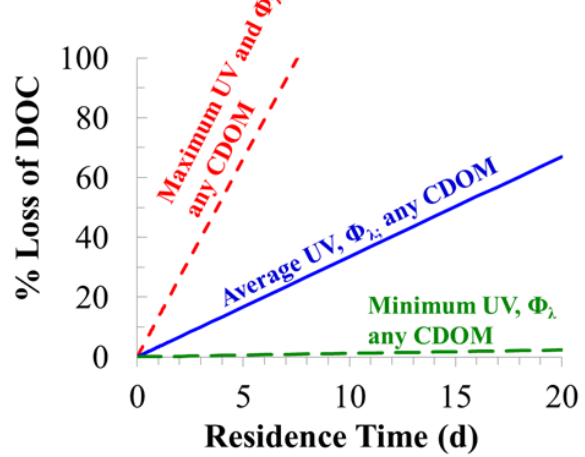
Figure 9. Cumulative percent of DOC loss in Imnavait Creek lost through photo-mineralization as calculated from Eq. 3 (removal of DOC as mol Cm − 2 d − 1 over the mean depth in Imnavait Creek; 0.5m) in Imnavait Creek using combinations of the range of surface UV light exposure, CDOM concentrations, and apparent quantum yields ( (cid:56) λ ) measured in this study for up to a 20-day residence time. For each scenario, the initial DOC concentration was set to 943µM C, the average surface water DOC concentration over both 2011 and 2012 (Table 2). Calculations do not include (1) the effect of DOC loss on changing light attenuation ( K d ) over the residence time (i.e., CDOM and thus K d ,λ remain constant over the residence time for each scenario), or (2) the effect of UV light exposure on (cid:56) λ over time ( (cid:56) λ , or DOM lability, remained constant over the residence time for each